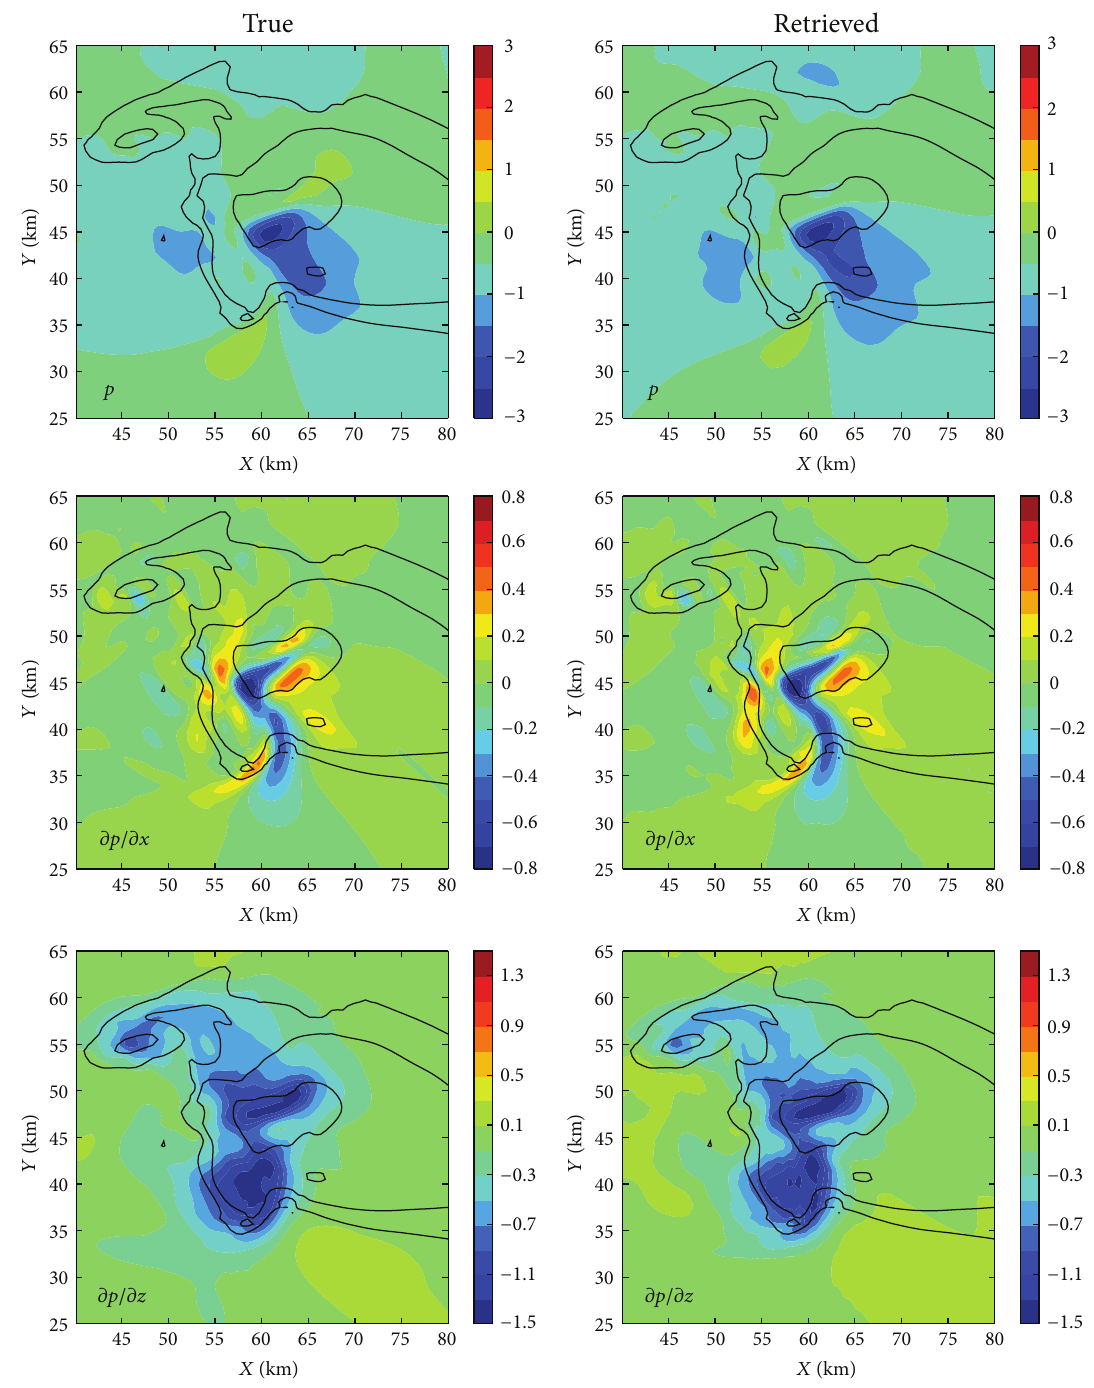
Figure 2: True (left) and retrieved (right) 𝑝 (top; hPa), 𝜕𝑝/𝜕𝑥 (middle; hPa km −1 ), and 𝜕𝑝/𝜕𝑧 (bottom; hPakm −1 ) at 𝑧 = 0.9 km. Radar reflectivity factor is contoured at 10, 30, and 50